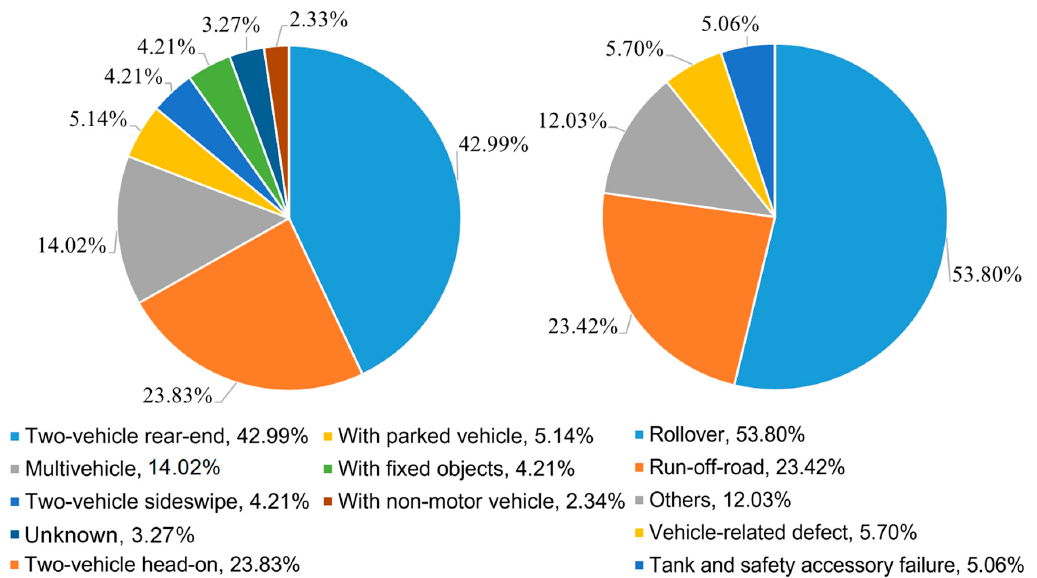
Figure 4. Collision and non-collision of the 371 HTAs.